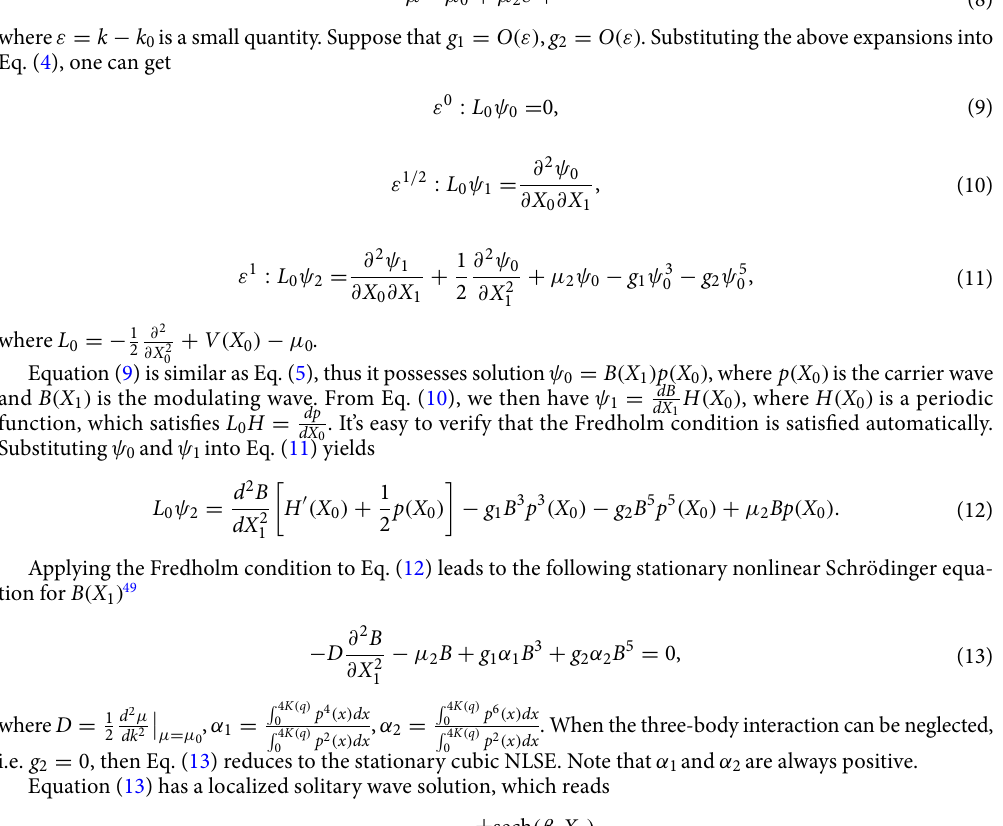
Figure 5a and b display the amplitude of the kinks and bubbles versus the chemical potential µ under different 1 ). nonlinear strength g 1 > 0 and g 2 < 0 . Here, we start computing from the points P 1 (corresponding to µ = 0.45, a 2 0.25 . The corresponding wave profiles at the marked a 3 The parameters for initial guess are a 1 = = − = − P 4 are shown in the subplots. The dashed lines denote the unstable points P 1 − solitons while the solid line denotes stable ones (The stable property will be discussed later.). Again, we see that the dark solitons can be excited in the band. It can be seen from Fig. 5a that the kink solitons exist in the first band and first gap, but it can not be excited in the semi-infinite gap. The amplitude of the kink increases as chemical potential µ increases. When µ moves from P 1 to P 2 , the amplitude becomes smaller distinctly. Both the amplitude of kink (modulation wave) and the amplitude of the Bloch wave (carrier wave) tend to zero as µ moves toward the lower edge of the first band. The kink soliton and the Bloch wave no longer exist when µ falls into the semi-infinite gap. From Fig. 5a, we suspect that the kink soliton may be regarded as a kink function, such as the tanh function, multiply by a Bloch wave function when the chemical potential µ near the lower edge of the first band. When it comes to the bubbles (see Fig. 5b), the numerical results are quite different to the kink ones. One can see that the amplitude of the bubbles decreases as µ increases. When µ falls into the semi-infinite gap, the gray soliton reduces to an on-site-like bright soliton (see the wave profile at point P 3 ). This is because the linearly periodic Bloch wave is prohibited in the semi-infinite gap. The profiles of this kind of solitons are similar to the bright solitons discussed before. However, they have different dynamical behaviors. The numerical results indicate that the on-site-like solitons are linearly unstable and dynamically unstable if µ is near the band edge. There is a critical value for µ . The on-site-like solitons are linearly and dynamically stable only when µ is less 1, g 2 0.5 ), the critical value for µ is about than this critical value. For the parameters used in Fig. 5b ( g 1 = = − 0.438. This critical value depends on the nonlinear strength g 1 and g 2 . From Fig. 5b, we suspect that the bubble soliton may be regarded as a superposition of a completely localized function and a Bloch wave function when µ near the lower edge of the first band. Multi‑scale method. We now make a theoretical analysis on the solitons obtained in the above